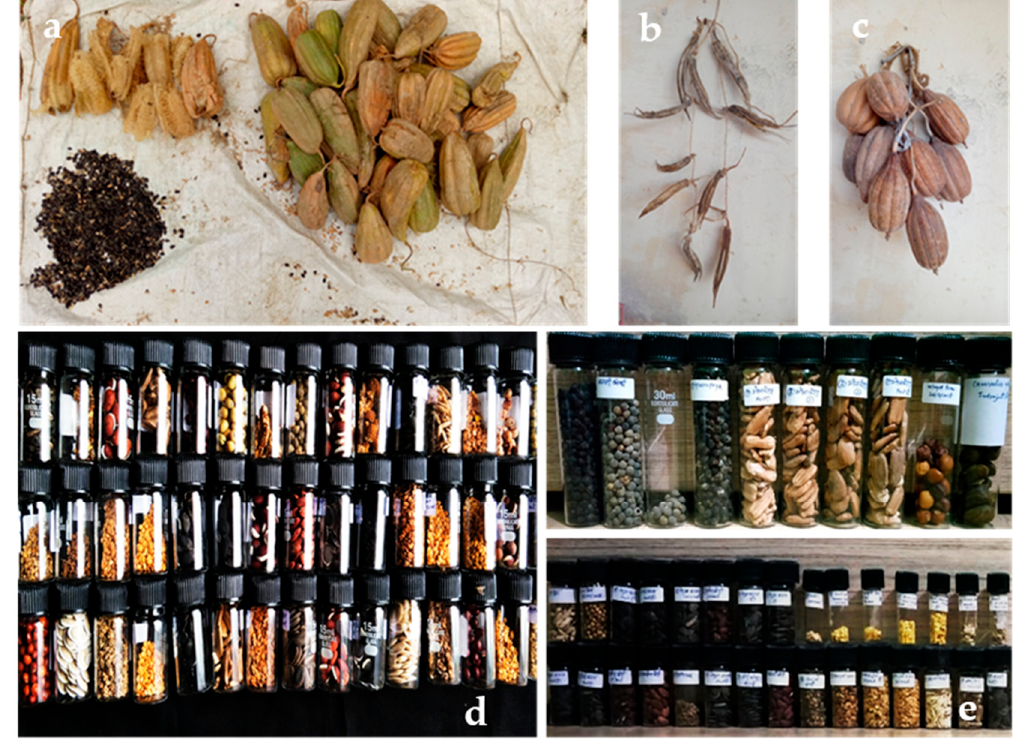
Figure 4. Apart from the exploration of wild and neglected crops, conservation of the germplasms of most promising species are also equally important for their sustainable utilization. For this, a blend of traditional ( a – c ) as well as modern ( d , e ) germplasm storage technologies should be adopted.